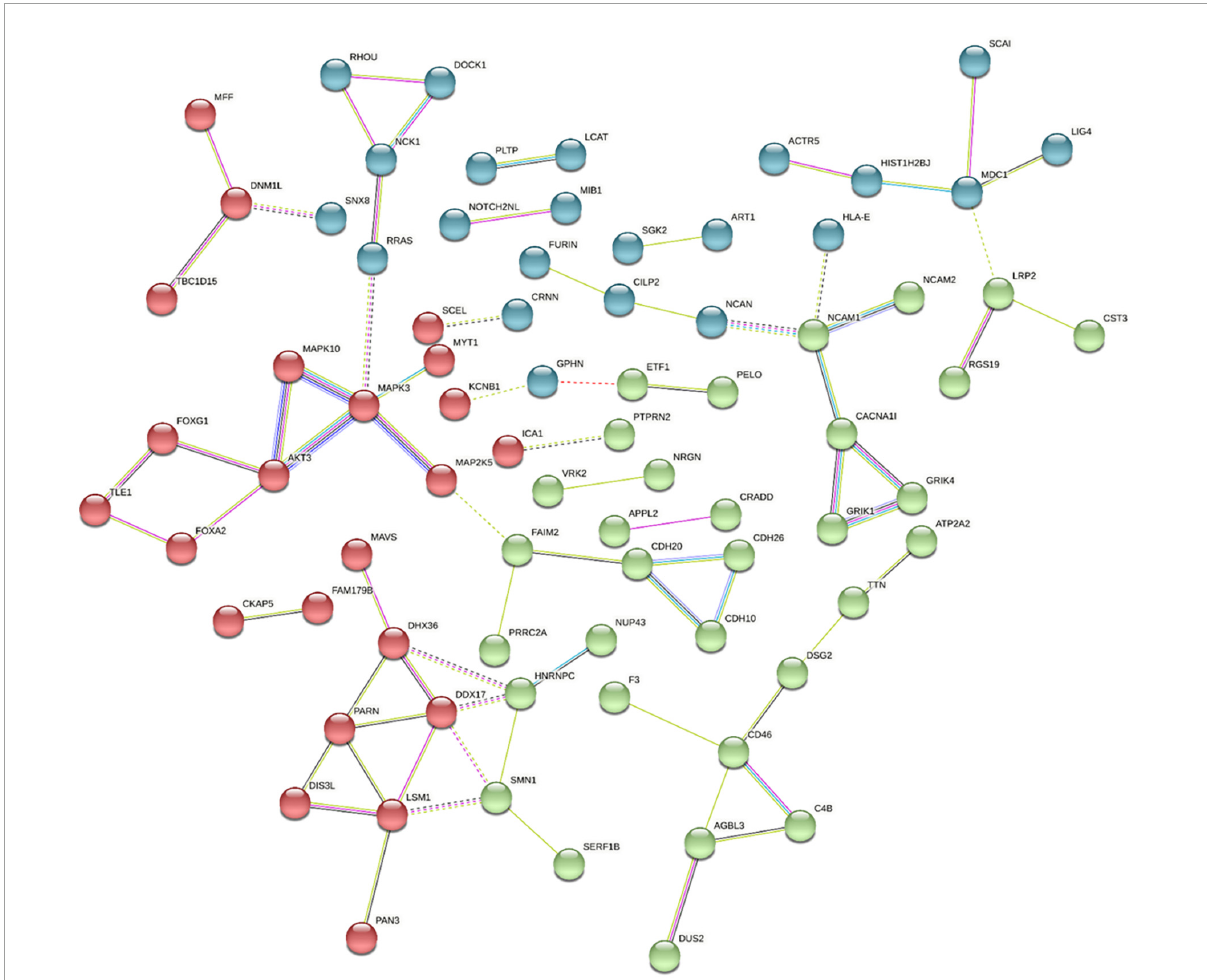
FIGURE4 Pathway and Gene Ontology analysis. Using the Cytoscape STRING app, a network was retrieved for the 159 promoters with differentially modified H3K9me2 occupancy. Genes with significantly increased or decreased H3K9me2 levels were selected by the diffReps program using a p -value > 0.05 and were entered in the “Network and Enrichment Analysis” within the STRING app. With a confidence cutoff of 0.4, kmeans clustering was used to generate 3 clusters (red, blue, and green). Resulting associations within and between clusters is depicted with solid and dotted lines, respectively. Different color lines indicates different type of interactions. (Cyan-from curated databases; Magenta-experimentally determined; Blue-gene co-occurrence; green-from text mining; Black-coexpression; lilac-protein homology; Red gene